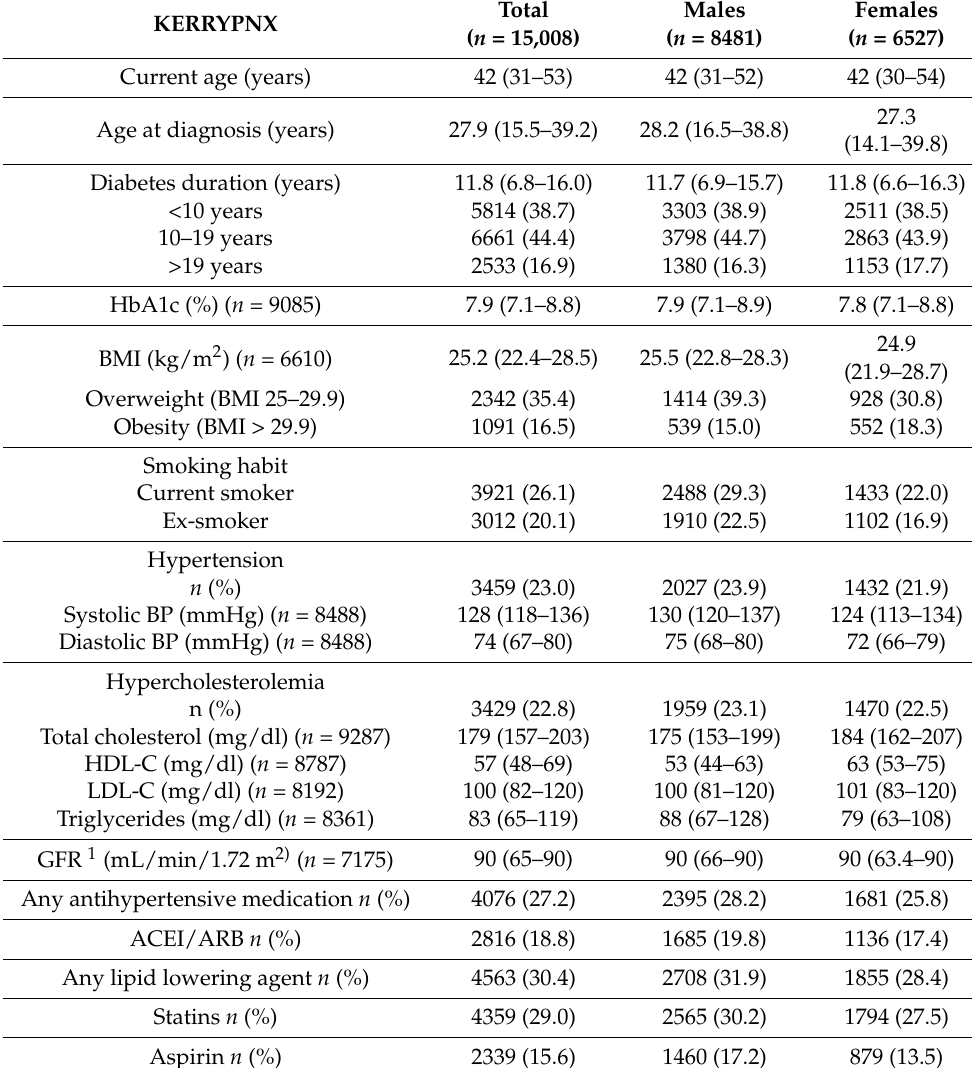
Table 1. Clinical characteristics and treatments of the study population according to